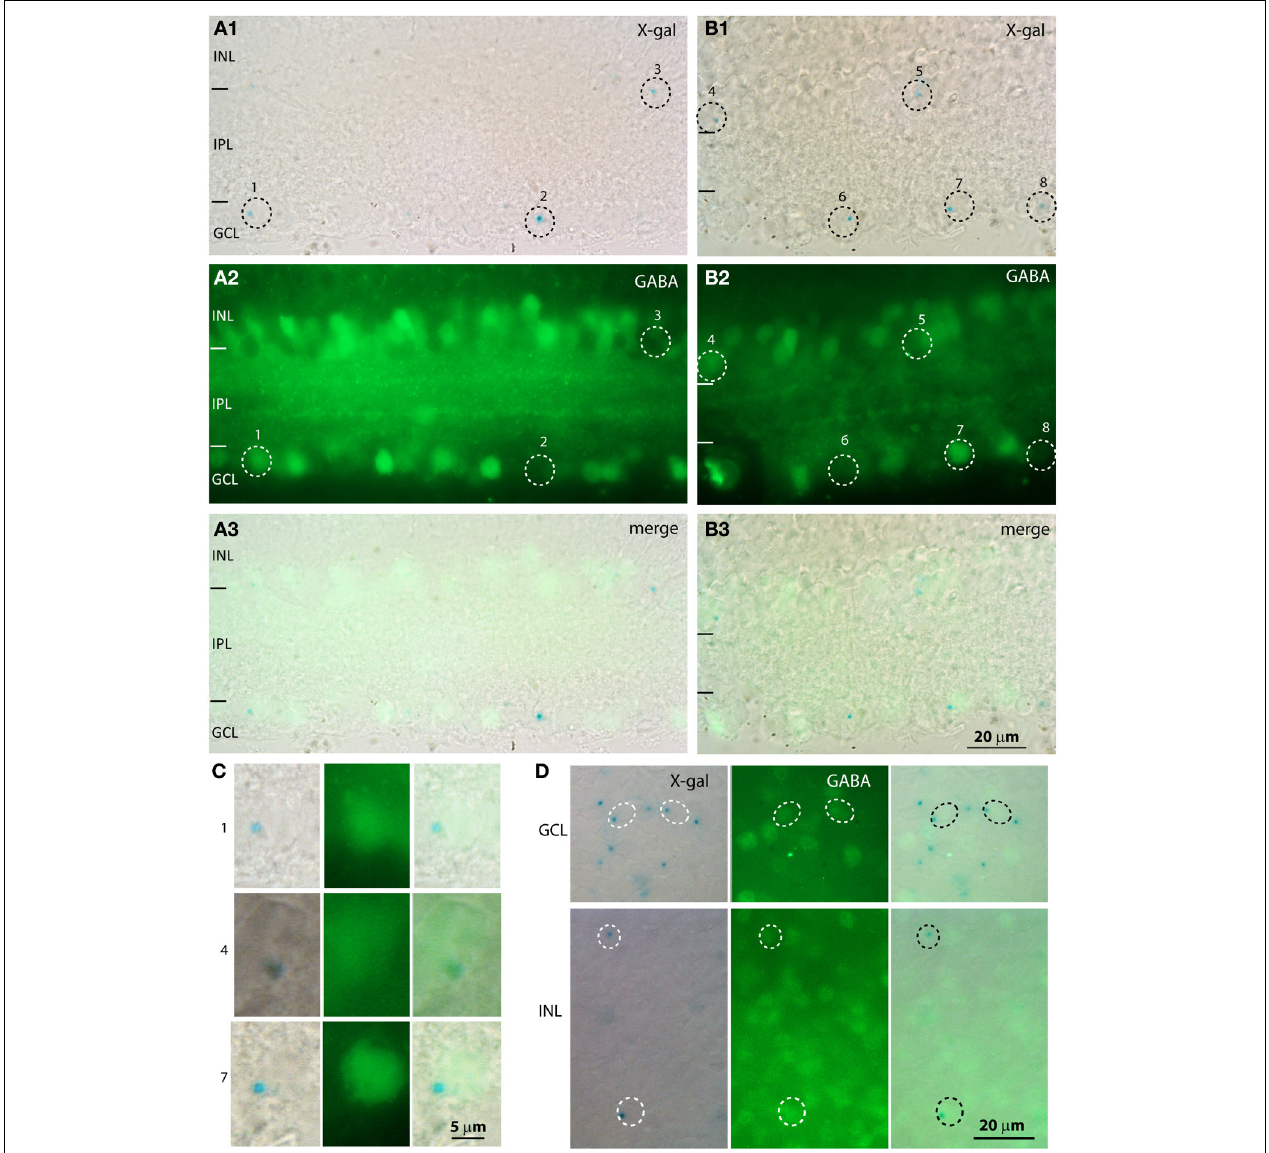
(numbers on the side correspond to numbers on the low magnification images) that are also positive for GABA. Cells 1, 7 are located in the GCL and cell 4 is located in the INL. (D) Whole mount preparations stained with X-gal reagent and for GABA show that some cells in both GCL and INL stained for both (circles), while several X-gal stained cells were negative for GABA and numerous GABA-immunoreactive cells were not stained with